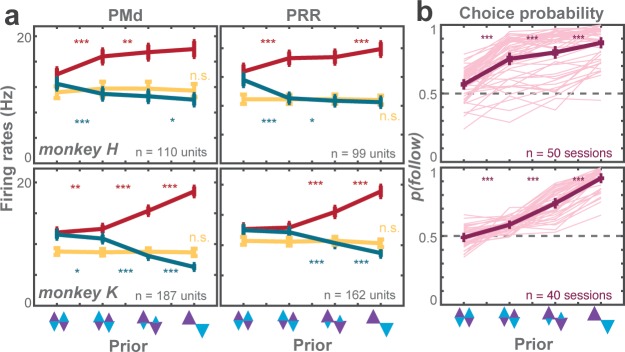
Planning-period activities reflect each monkey’s choice bias as function of action priors.(a) Neuronal population responses in PMd (left) and PRR (right) for monkey H (top row) and K (bottom row) as function of action prior for different prior directions relative to the PD of the neurons (conventions as in Figure 4a & c). (b) Average choice probabilities of monkey H (top) and monkey K (bottom) as function of prior. Conventions for pairwise comparisons: *p < αcorr at 5%, **p < αcorr at 1%, ***p < αcorr at 0.1%; Bonferroni-corrected t-test.